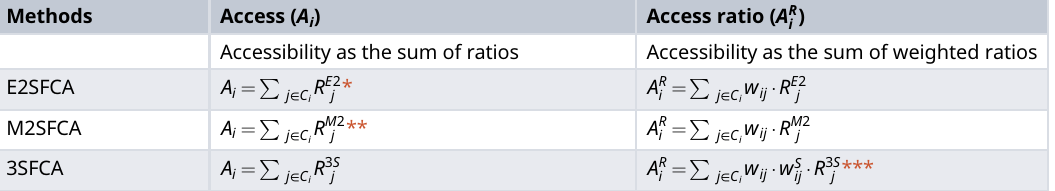
Table 1. Model formulas of access ( A i ) and access ratio ( A R i ), where E2SFCA is the enhanced two-step floating catchment area (FCA), M2SFCA is the modified two-step FCA, and 3SFCA is the three-step FCA.